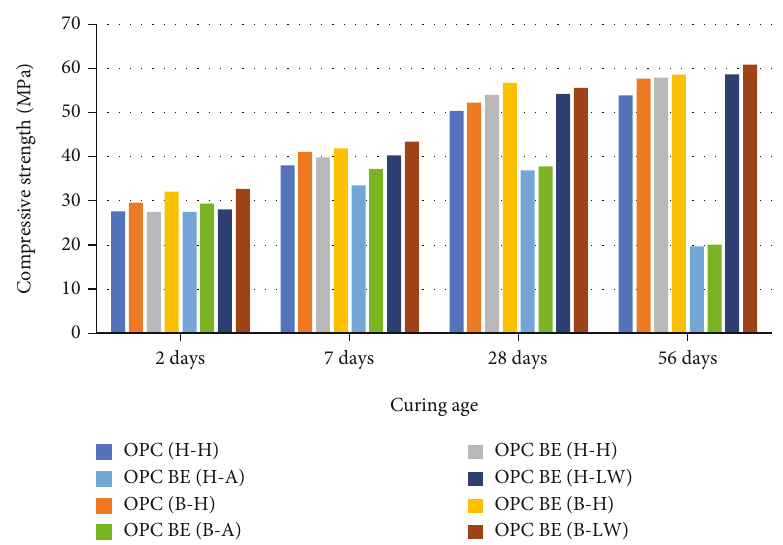
Figure 2: Compressive strength results of OPC test mortars at 2nd, 7th, 28th, and 56th day of